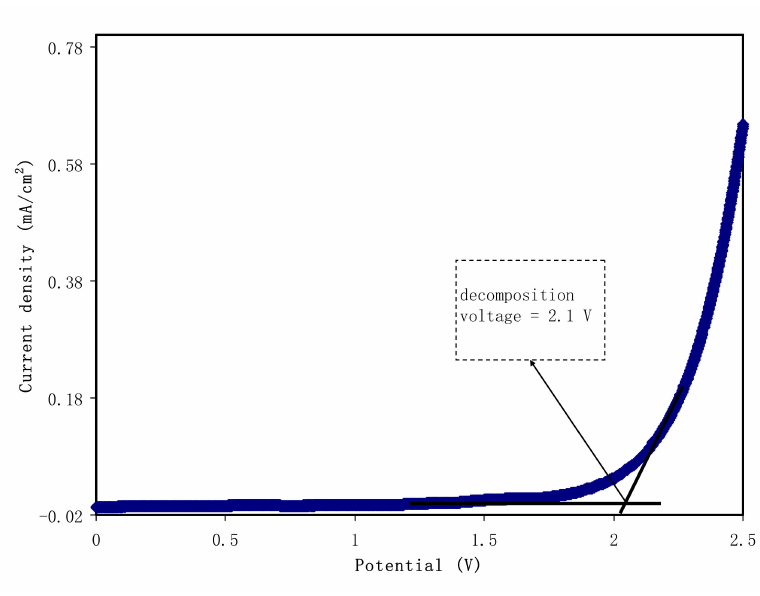
Figure 9. Linear sweep voltammetry plot for the CSAG4 sample with maximum conductivity.